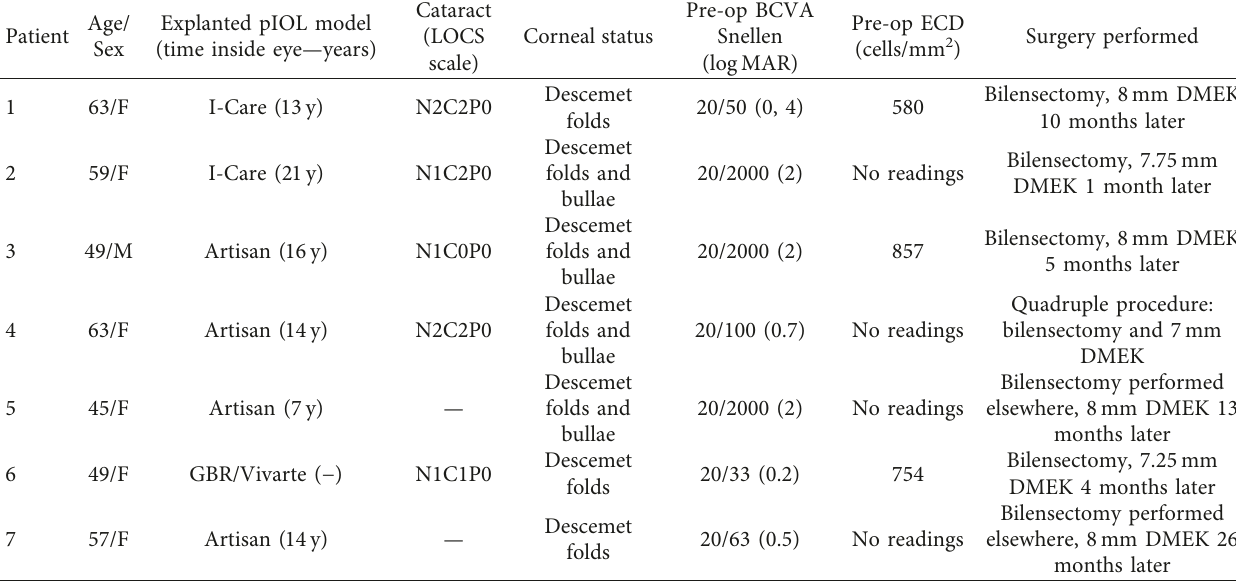
Table 1: Preoperative data and surgical details of the seven